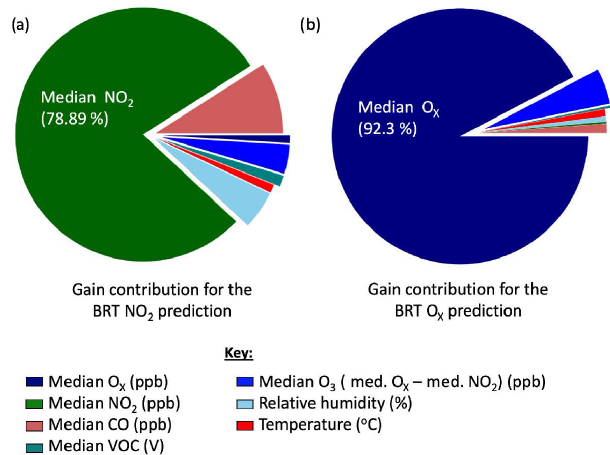
Figure 5. Breakdown of contribution from each variable used by the BRT algorithm to predict the clustered (a) NO 2 sensor and (b) O x